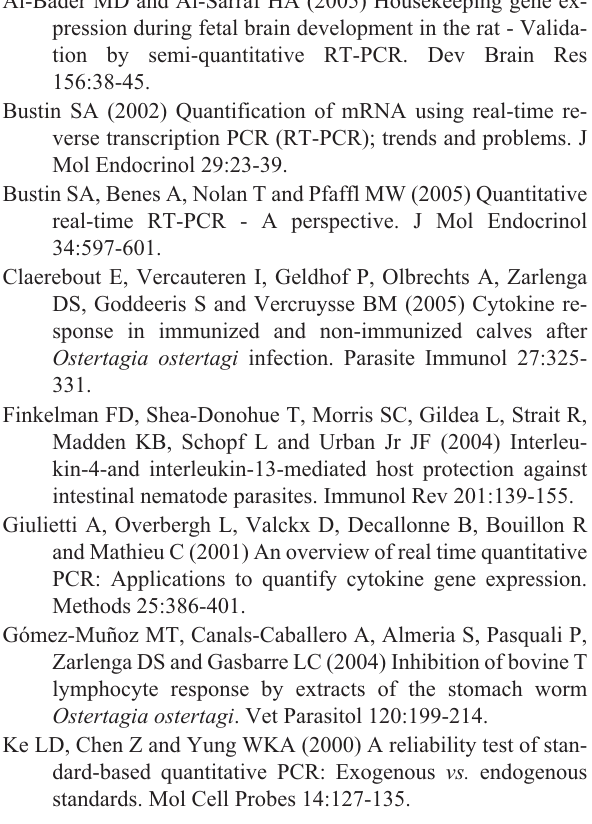
Values with different letters in the same row are statistically different (p <